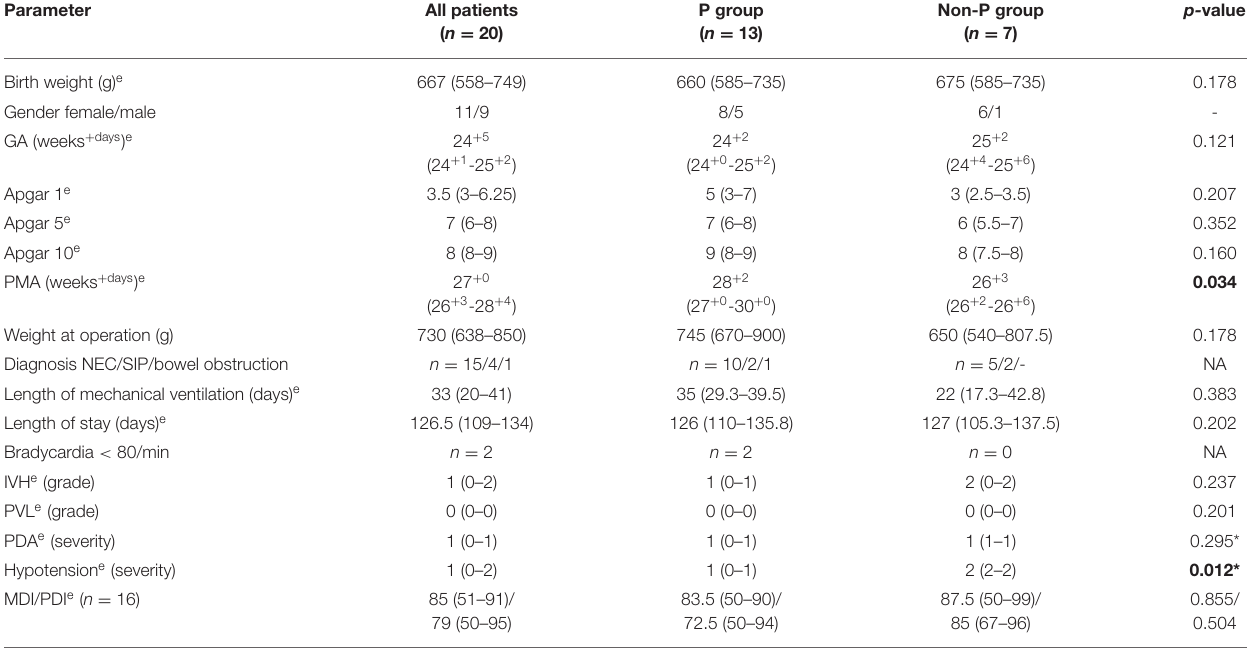
TABLE 1 | Study population and outcome parameters. Parameter